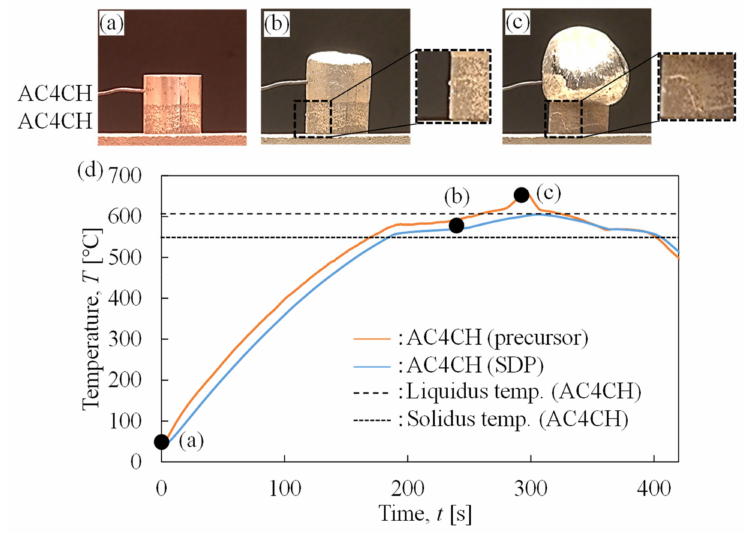
Figure 4. Foaming behavior and corresponding temperature history of AC4CH/AC4CH. ( a ) Begining of heat treatment. ( b ) Gradual foaming of upper AC4CH layer. ( c ) Sufficient foming of upper AC4CH layer. ( d ) Foaming time t –temperature T relationships.